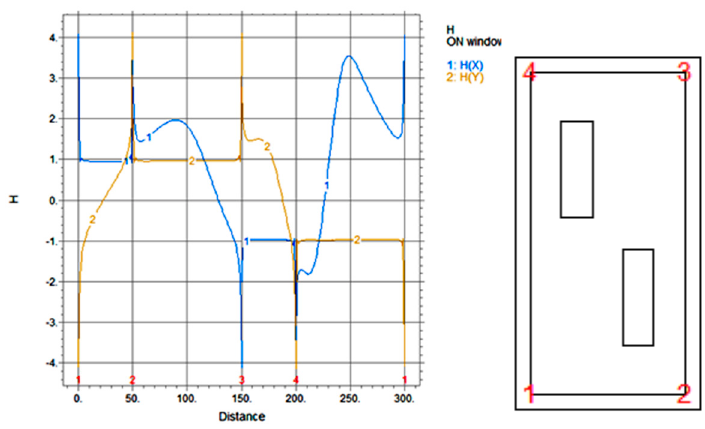
Figure 6. Components of the magnetic field H x ( x , y ) and H y ( x , y ) along boundaries.